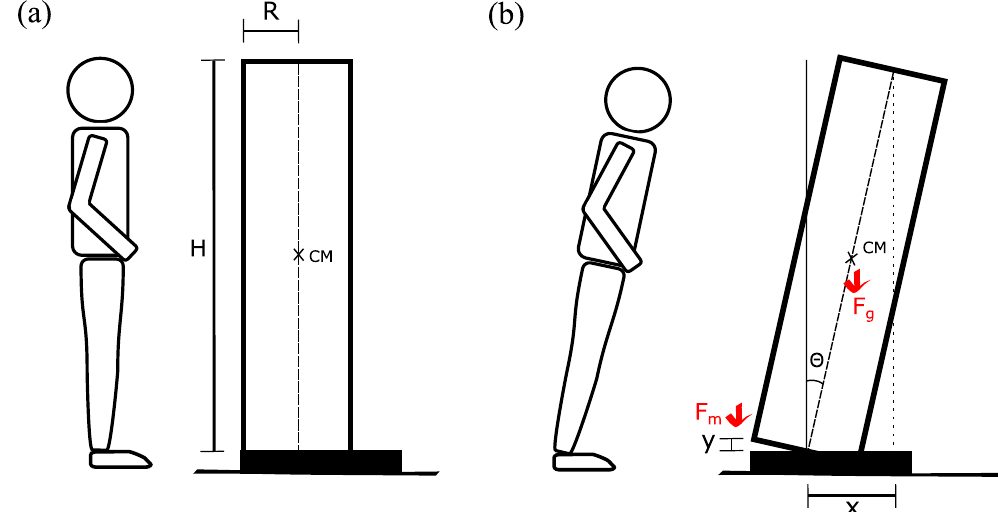
Figure 3. ( a ) We assume that the human body is a uniform cylinder with the radius R and the height H . It is supported on a rigid substrate (a representation of human feet). Suppose that the human body cylinder is tilted forward as shown in ( b ) by a small angle θ . To achieve the stability of the tilted posture, two competitive torques, one from the skeletal muscle force F m and the other from the gravitational force F g , must be balanced. The gravitational torque is written as T g = F g ( x /2) with x /2 being the shift of the horizontal position of the center of mass (CM). We assume that F m depends on the extension y of muscles as shown in ( b ). For the tilting angle θ , we get θ = x H sin and θ = = y R xR H sin /